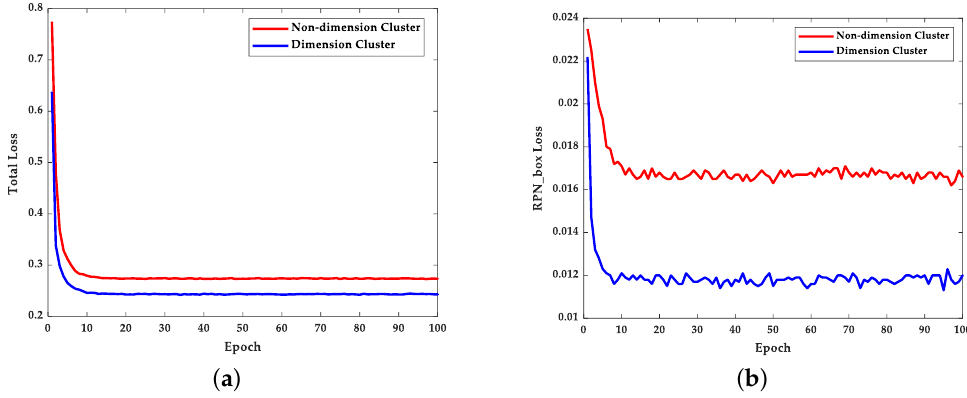
Figure 25. Variation in losses with the training epoch. ( a ) Variation in total loss with the training epoch. ( b ) Variation in box loss of RPN with the training epoch.